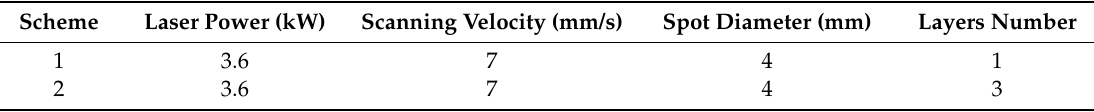
Table 2. Processing parameters for laser cladding and cladding layers.